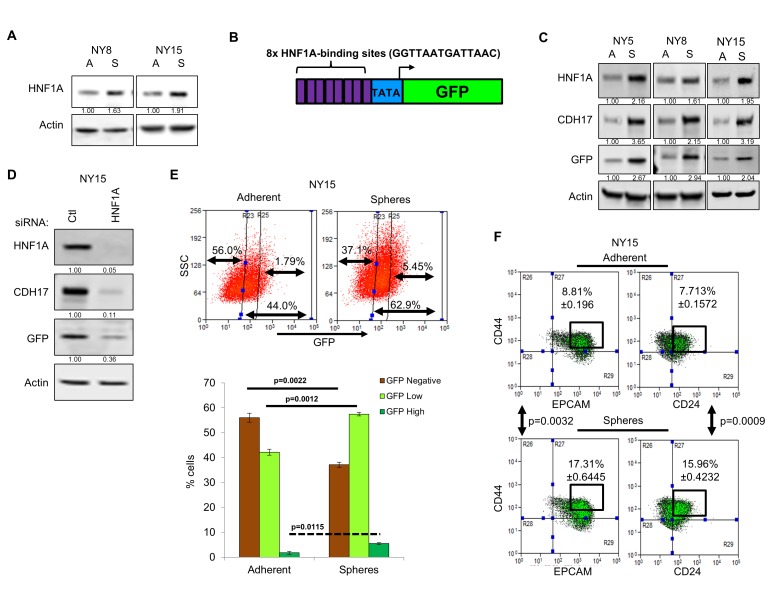
HNF1A is elevated in tumorspheres.(A) NY8 and NY15 cells were grown either in non-adherent conditions (labeled S) or under adherent conditions (labeled A) for 7 days. Lysates were collected and western blotted for HNF1A, CDH17, and Actin. Quantitation of proteins is indicated below the respective blots. (B) Schematic representation of HNF1A-responsive reporter construct showing eight tandem copies of the HNF1A-binding site upstream of a minimal promoter (pTA) driving GFP expression. (C) HNF1A-reporter-labeled NY5, NY8, and NY15 cells were grown under adherent (A) or tumorsphere (S) conditions for 7 days, lysed and immunoblotted for HNF1A, CDH17, GFP, and Actin. Quantitation of proteins is indicated below the respective blots. (D) Reporter cells were transfected for 7 days with control (Ctl) or HNF1A-targeting siRNA, lysed and immunoblotted for HNF1A, CDH17, GFP, and Actin. Quantitation of proteins is indicated below the respective blots. (E, F) NY15 reporter cells grown under adherent or tumorsphere conditions were collected by trypsinization and analyzed by flow cytometry for GFP fluorescence and EPCAM, CD44, and CD24 surface staining. Representative flow cytometry plots and quantitation of GFP expression are shown in the upper and lower panel of (E), respectively. Statistical difference was determined by unpaired t test with Welch's correction (n = 3). (F) Flow cytometry plots showing co-localization of GFP with EPCAM, CD44, CD24 are shown. The percentage of CD44High/EPCAMHigh/GFP+ or CD44High/CD24High/GFP+ cells is indicated as a mean ± SEM (n = 3). Statistical difference between adherent and sphere cells was determined by unpaired t test with Welch's correction, and respective p values are indicated.